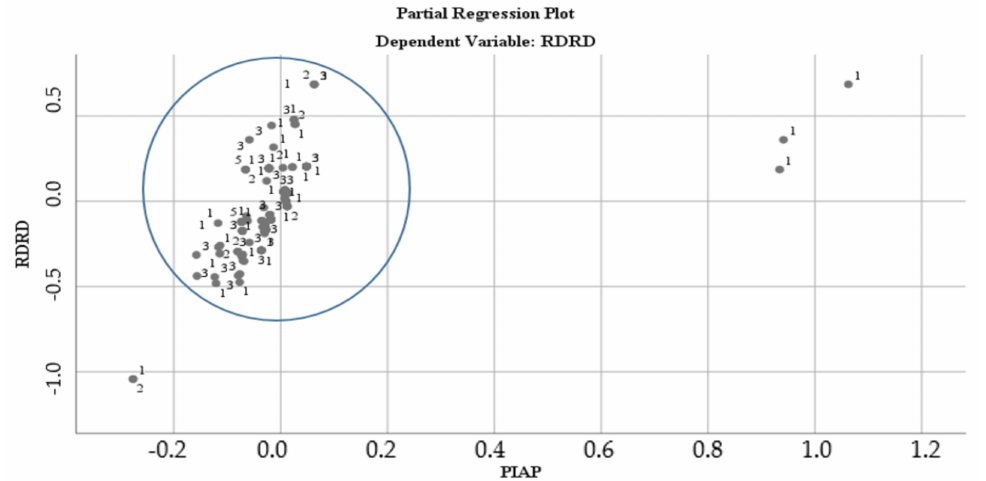
Figure 15. Regression analysis for